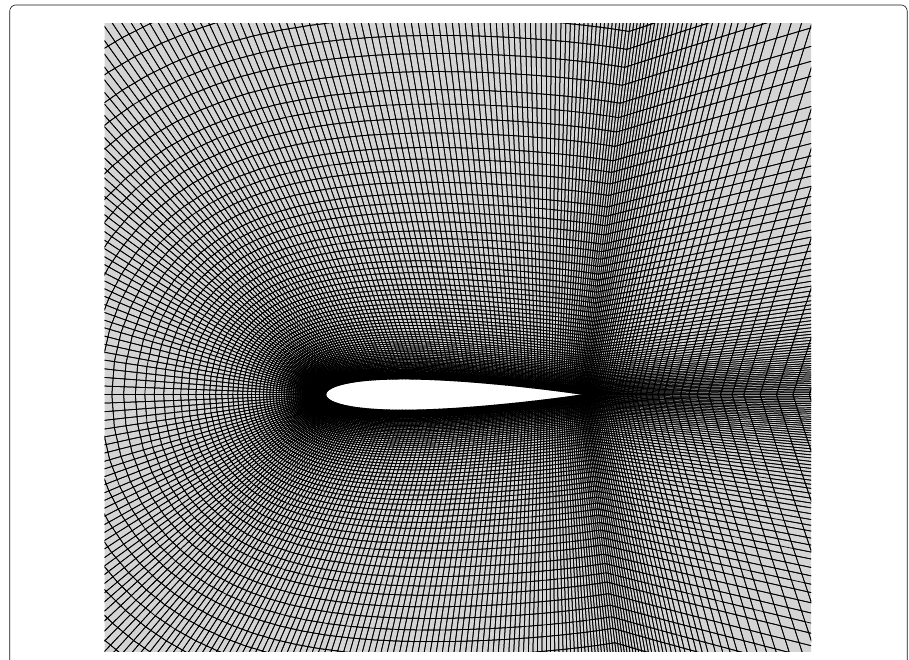
Fig. 6 A fine mesh for NACA0012 test case in the 2D Euler